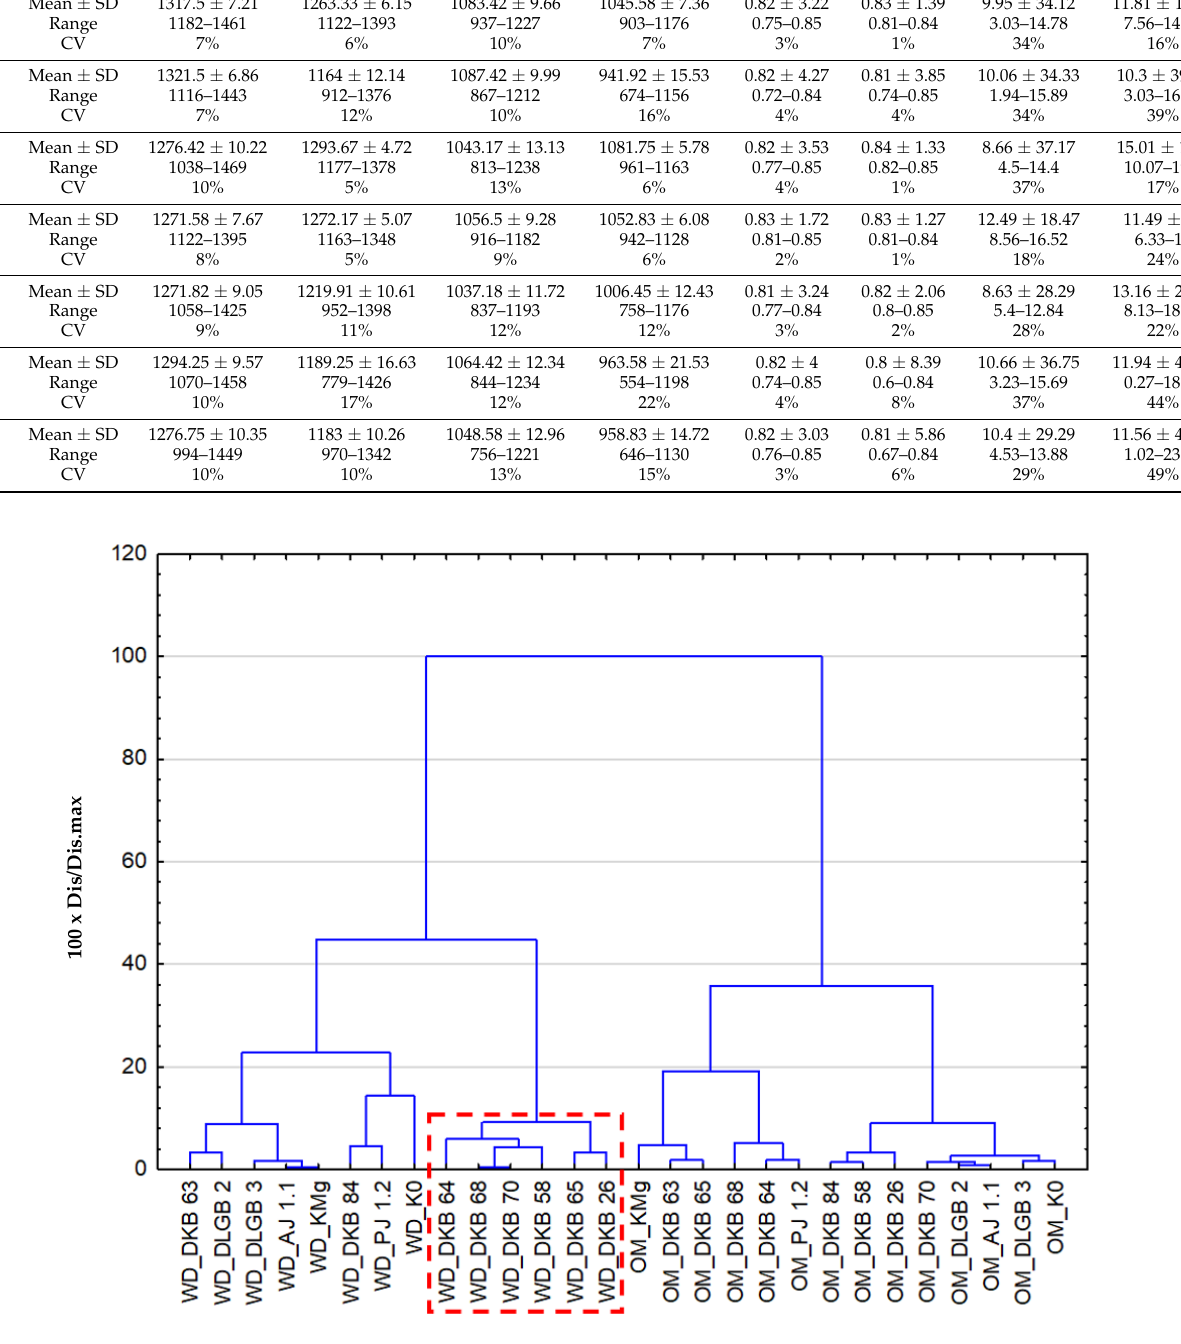
Figure 3. Cluster analysis showing the similarities of the variability of chlorophyll “a” fluorescence indices, depending on the different substrate moisture levels and inoculation with rhizosphere bacteria, where: OM—optimal moisture, WD—water deficit.